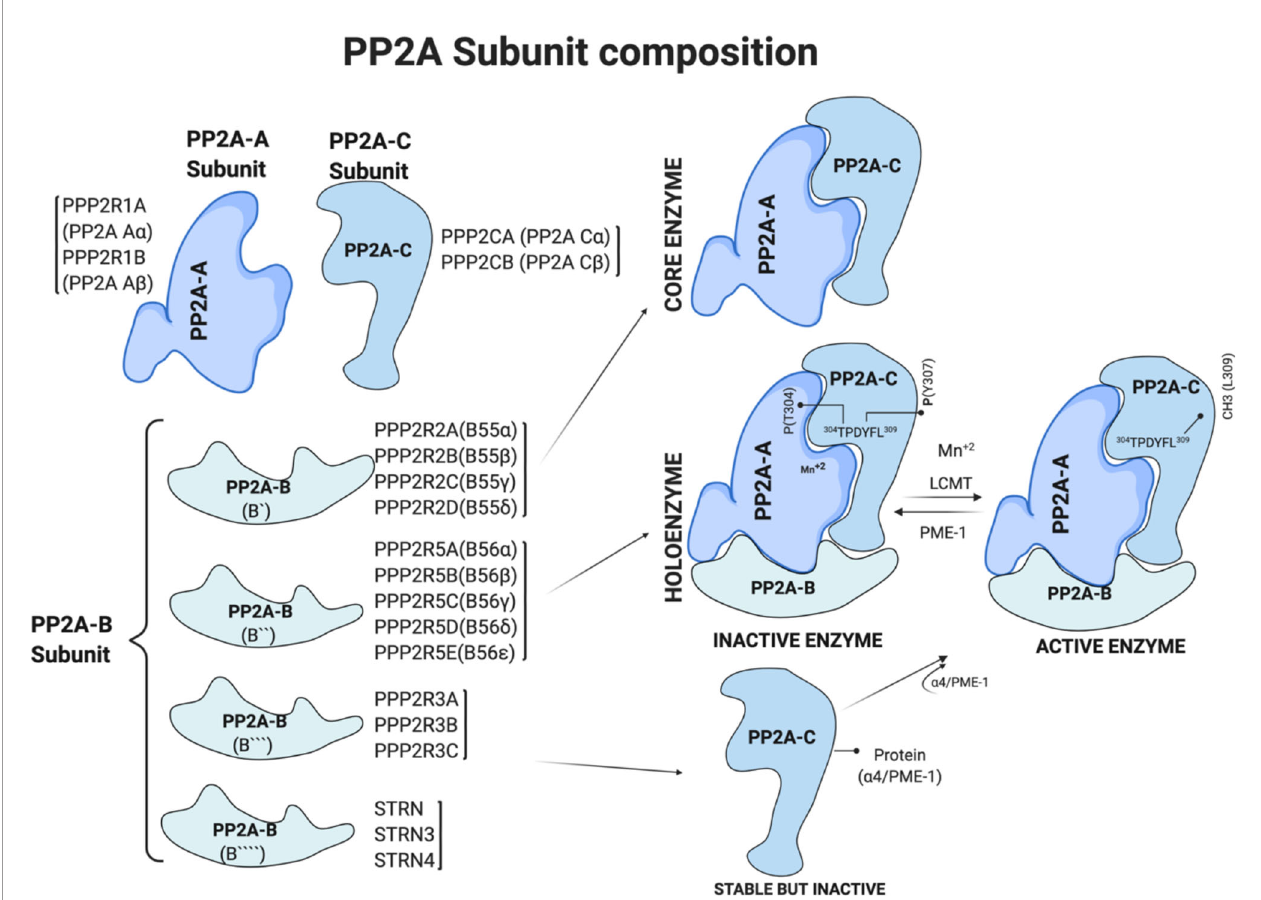
FIGURE 1 | PP2A subunit composition and regulation of PP2A holoenzyme by post translational modi fi cation. Generated based on (4, 7). Figure 1 is modi fi ed from the thesis (24) and prepared using